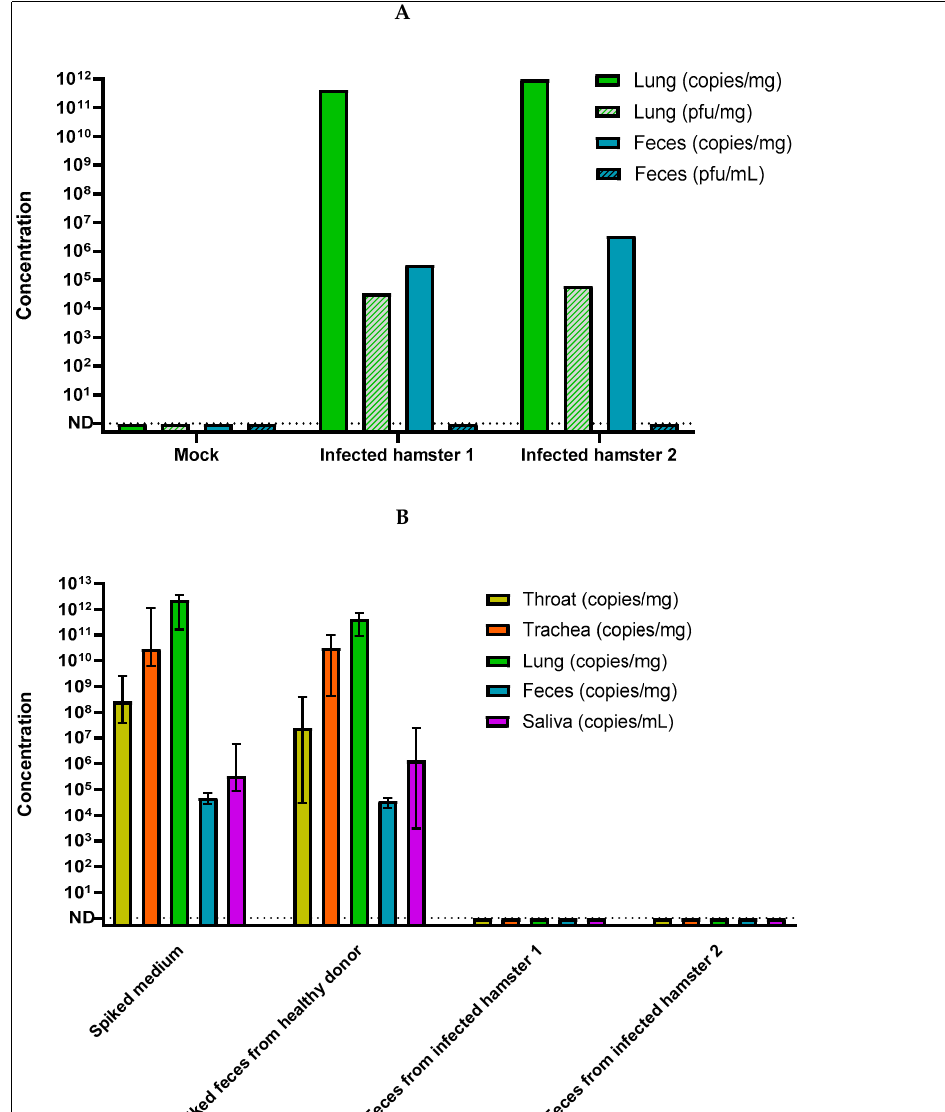
Figure 3. Detection of SARS-CoV-2 in different hamster organs 4 days post infection. ( A ) Quantifi- cation of viral RNA in SARS-CoV-2 infected donor hamsters by RT-qPCR and infectious particles by endpoint plaque assay was done in lungs and feces of animal. RNA genomes and infectious viruses were detected in lung whereas only viral RNA was detected in feces of infected animal. ( B ) Quantification of viral RNA in groups of recipient hamsters after intranasal instillation of fresh feces from infected donor specimens or feces from healthy donor spiked with infectious virus. As a positive control, hamsters were infected by virus spiked medium. Hamsters infected by virus-spiked feces samples developed similar infection pattern than specimen infected with positive control. Hamsters infected with feces from infected donor hamster did not present viral genomes in the different compartments analyzed. The concentration was measured by RT-qPCR and was indicated in copies per mg of tissue or mL of saliva.